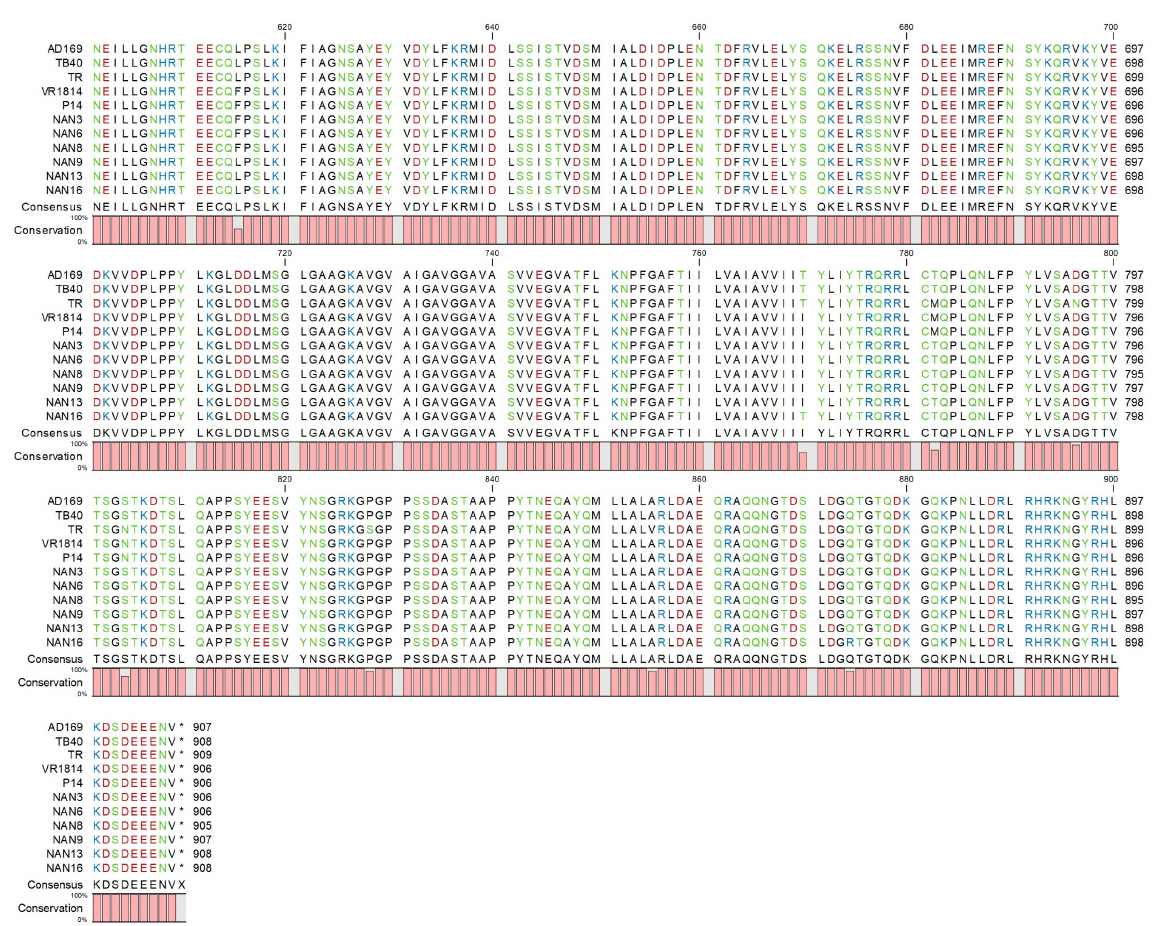
Figure 1. Amino acid sequence alignment of HCMV gBs discussed in this study. The D275Y and S585G variants are marked with an asterisk (*).